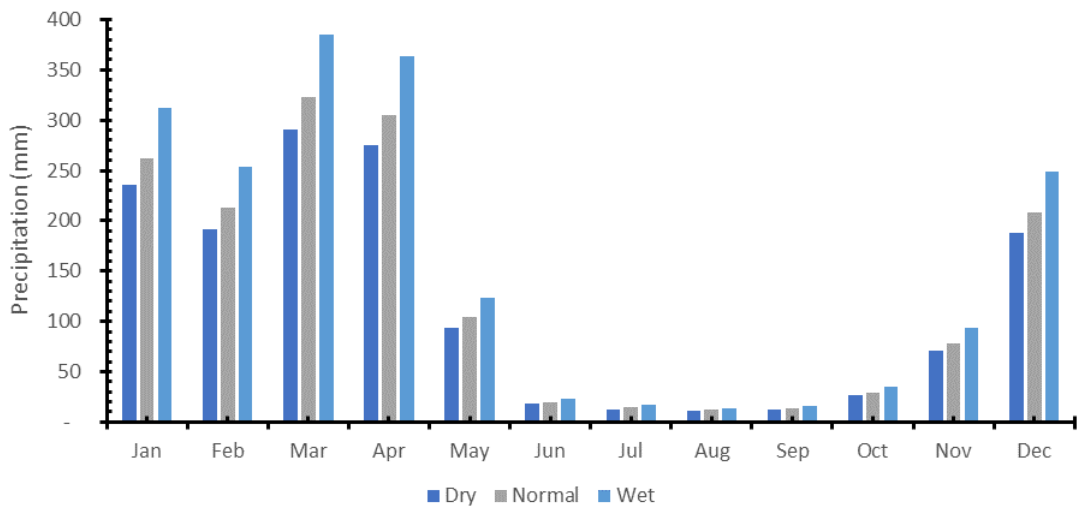
Figure 3. Dependable rainfall in Kilombero river catchment.